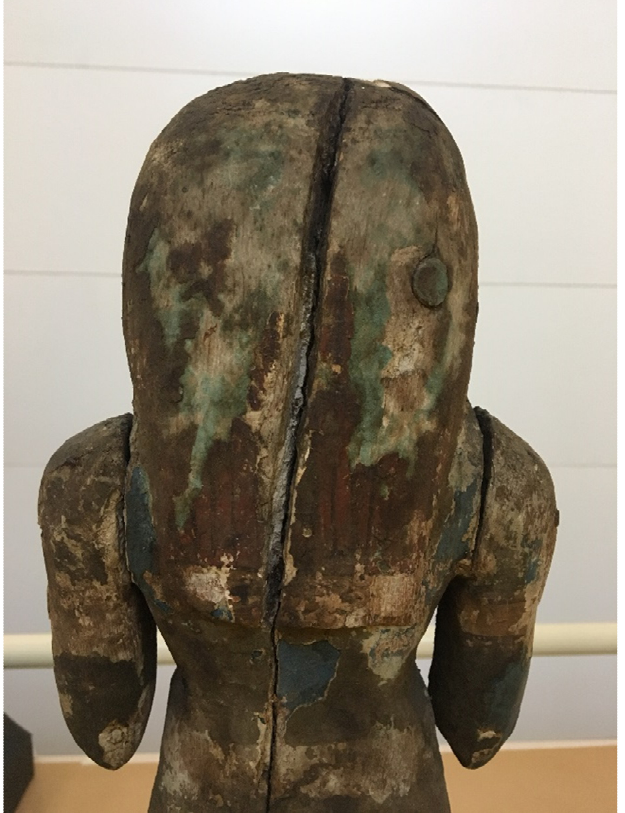
Figure 3. Detail of the back of the case study. It can be seen that different paint layers are covered with